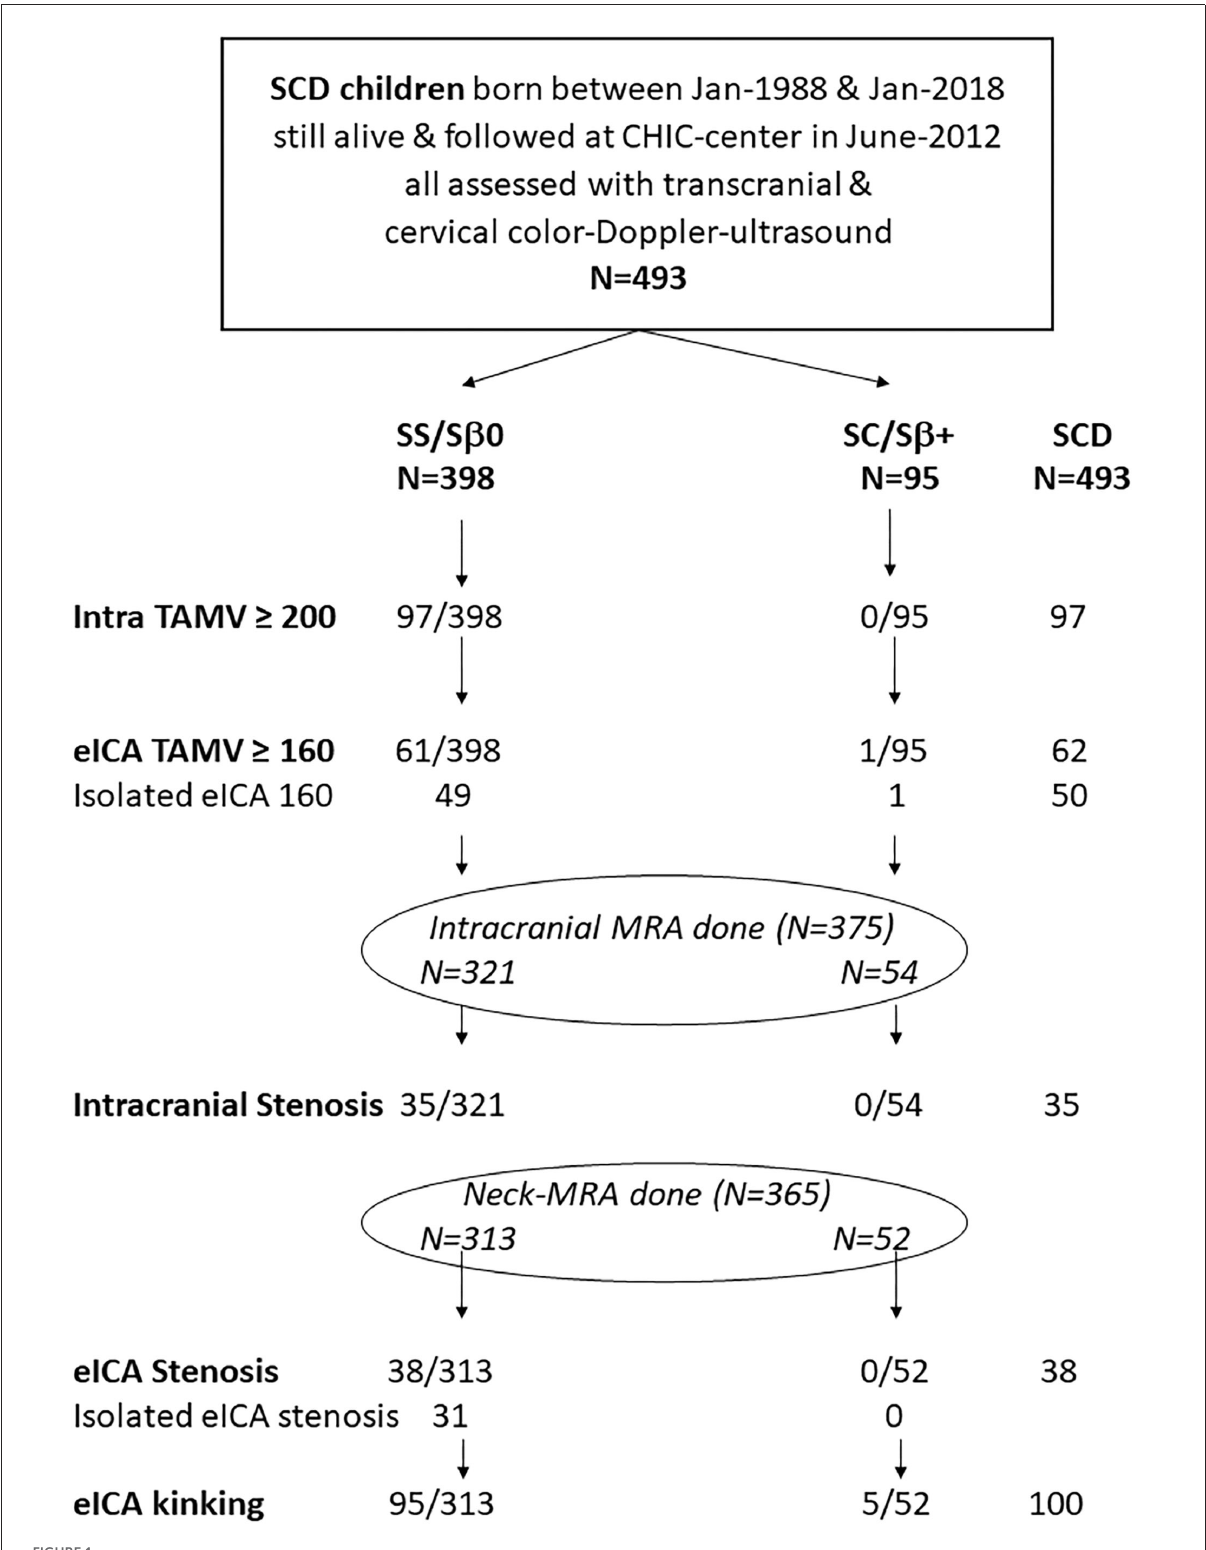
FIGURE1 Flowchart of the newborn SCD cohort study systematically assessed by transcranial and cervical color Doppler